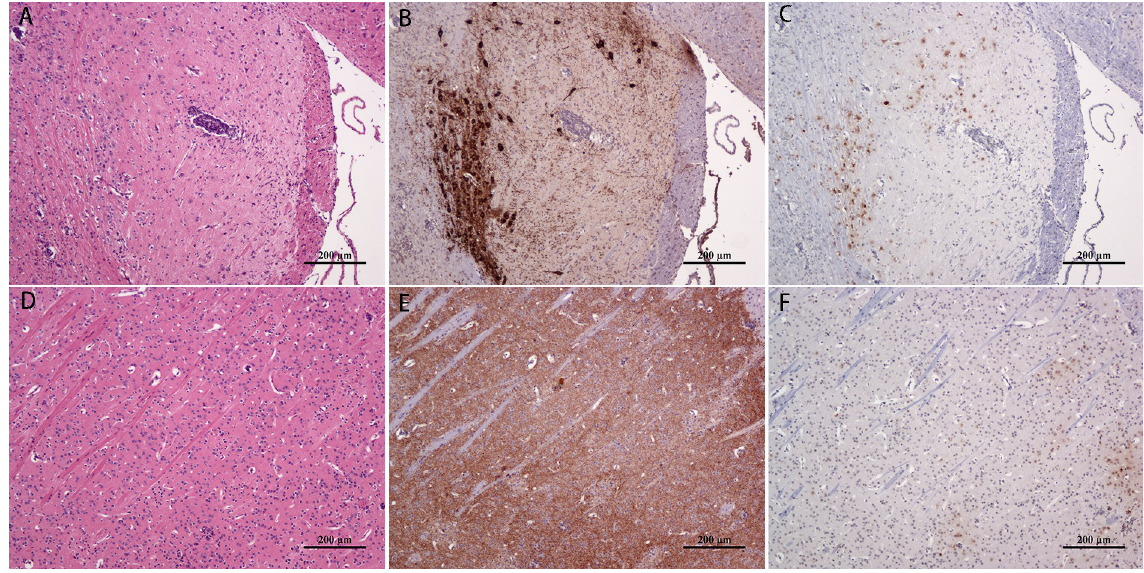
Fig 3. Co-localization of viral antigens in mouse brain nuclei 4 d post JEV infection. HE staining of the (A) substantia nigra and (D) striatum. immunohistochemical staining of tyrosine hydroxylase (brown) in corresponding areas of the (B) substantia nigra and (E) striatum. immunohistochemical staining of the JEV E protein antigen (brown) in corresponding areas of the (C) substantia nigra and (F) striatum.